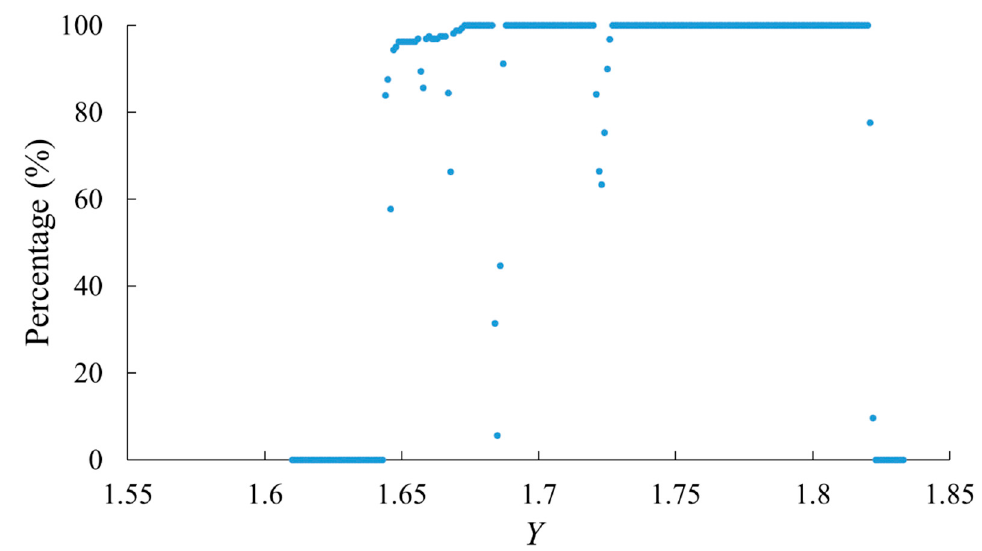
Figure 12. The percentage chance that AIII survives the gain shift as a function of Y.